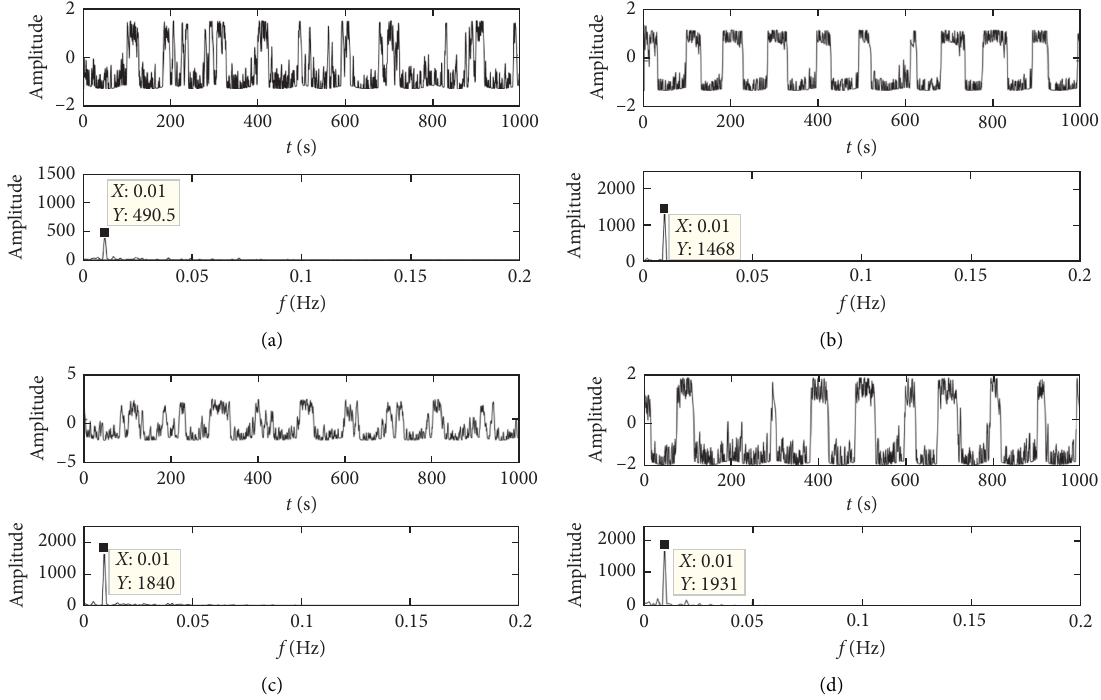
Figure 5: (a) Output of the symmetric system SR model and its power spectrum. (b) Output of SR model with asymmetric depth of the ( x )) and its power spectrum. (c) Output of SR model with asymmetric width of potential well ( u potential well ( u 1 spectrum. (d) Output of SR model with asymmetric depth and width of potential well ( u